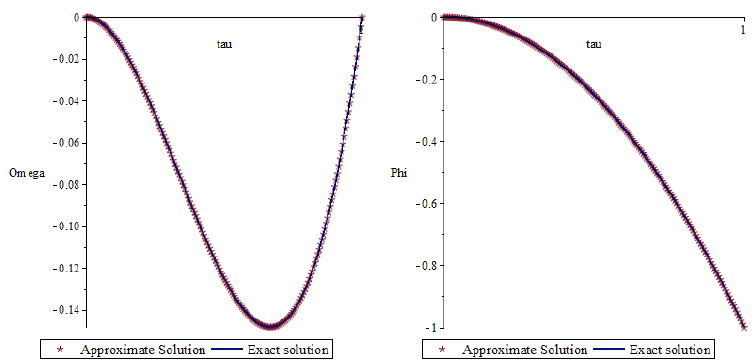
Figure 1. Comparison of exact solutions Ω and φ and approximate solutions Ω n and φ n , respectively, for the first example, where n =